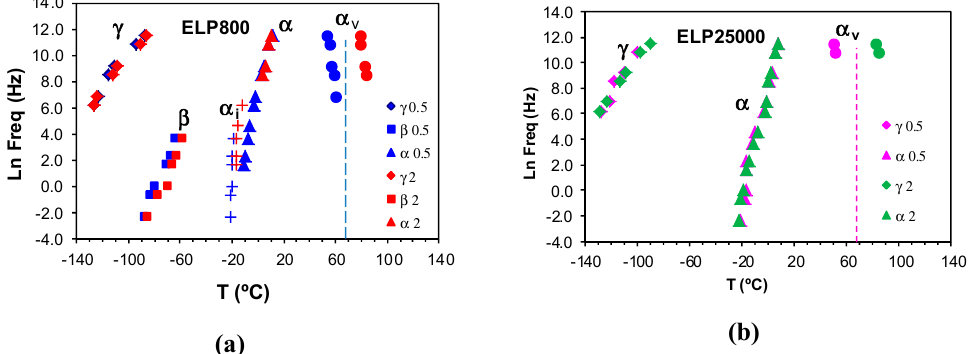
Figure 9. Temperatures of the relaxations peaks for the uncured ( a ) ELP800 and ( b ) ELP2500 samples at different heating rates: 0.5 °C/min (ELP800, blue symbols; ELP25000, pink symbols) and 2 °C /min (ELP800, red symbols; ELP25000, green symbols). The vertical dashed line shows the vitrification temperature obtained by TOPEM from c p0 at 0.5 °C/min.